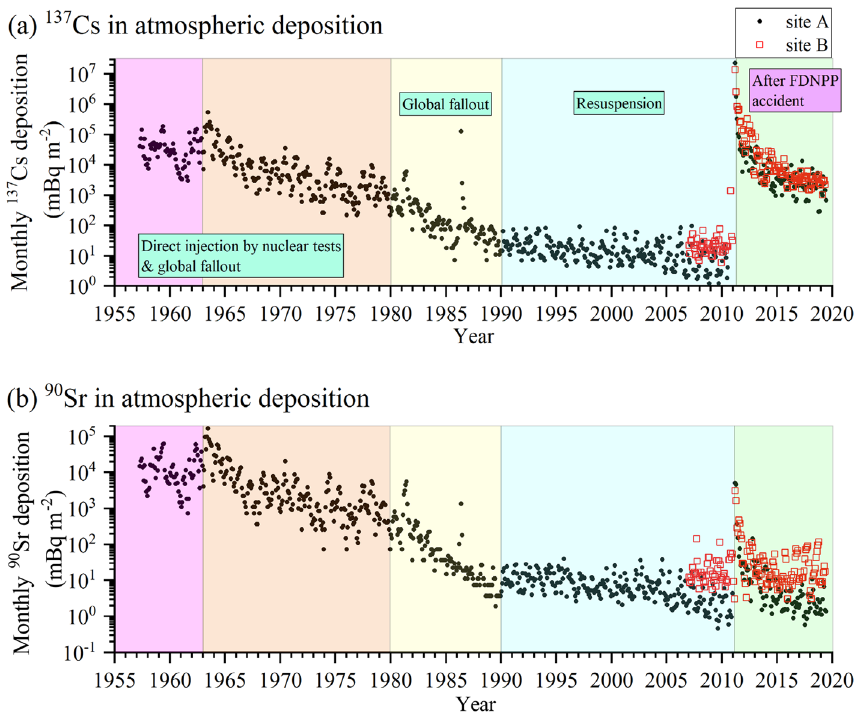
Figure 1. Historical observation of the activity of ( b ) 90 Sr and ( a ) 137 Cs in atmospheric depositions (mBq m −2 ) and the change from 1957 to 2019 at site A (closed black circles) and that after 2007 at site B (open red